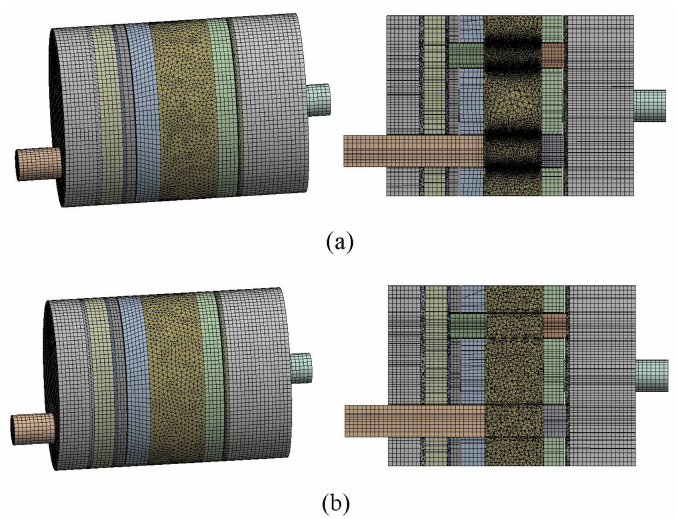
Figure 8. Mesh model for the three-pass perforated tube silencer: ( a ) computational fluid dynamics (CFD) mesh model; ( b ) acoustic mesh